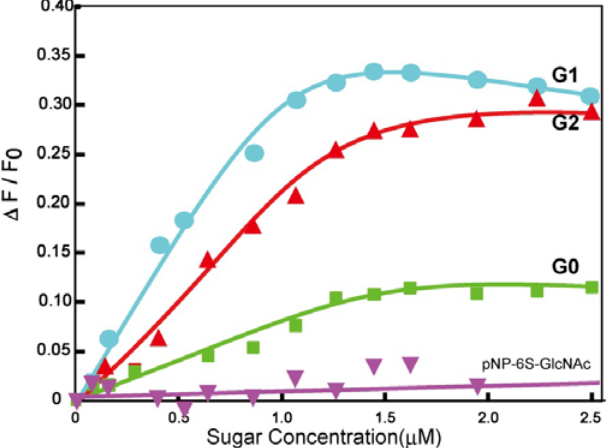
Figure 2. Fluorescence intensity changes of the FITC-WGA with varying sugar concentrations of the sulfonated GlcNAc derivatives.